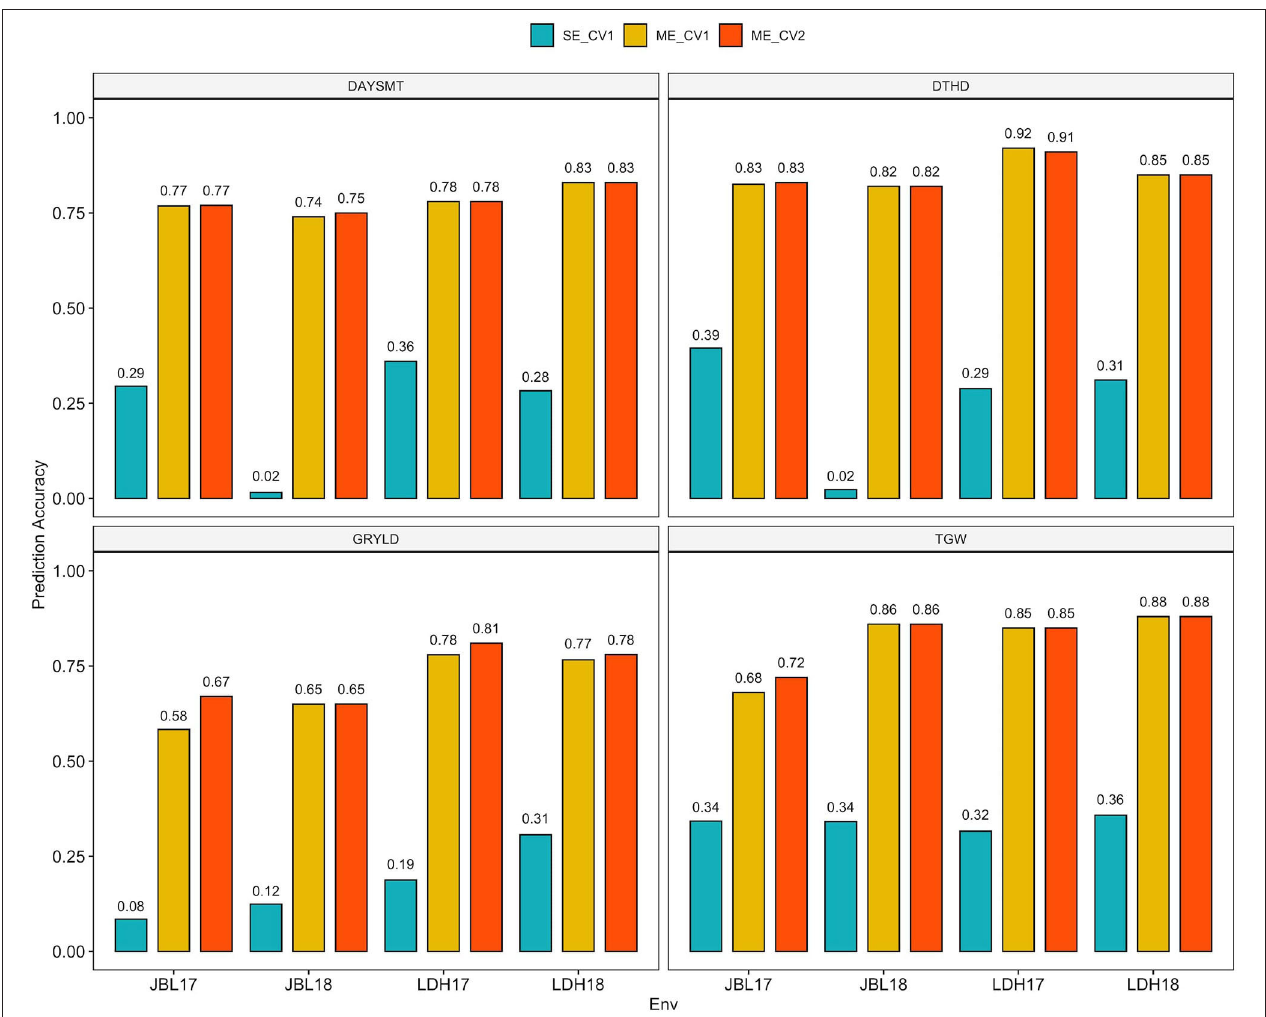
FIGURE 3 | Bar plots showing the prediction accuracy (PA) of DAYSMT, DTHD, GRYLD, and TGW using SE and ME models from individual experiments across locations (LDH17, LDH18, JBL17, and JBL18). SE_CV1 predicting SE at a time, ME_CV1 predicting new lines with genotypic information only, and ME_CV2 predicting partially phenotyped lines by using genotypic and phenotypic information from all traits from individuals in the training set, and genotypic and correlated phenotypic traits in the testing set.